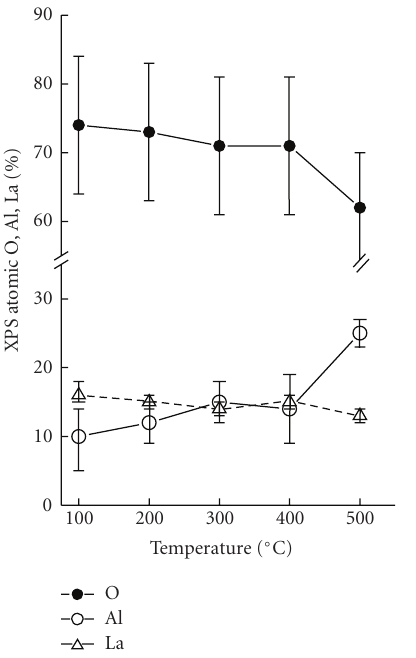
Figure 4: Evolution of composition with temperature for the Ce- treated